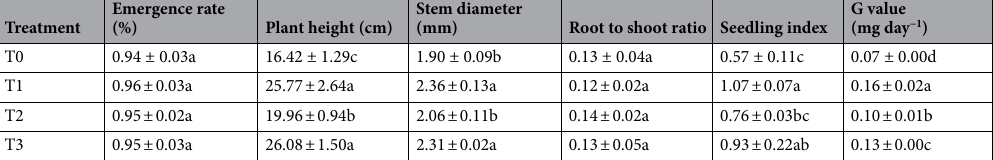
Table 4. Effects of the mixture of rice husk ash and red soil with various proportions on growth parameters of cotton seedlings.